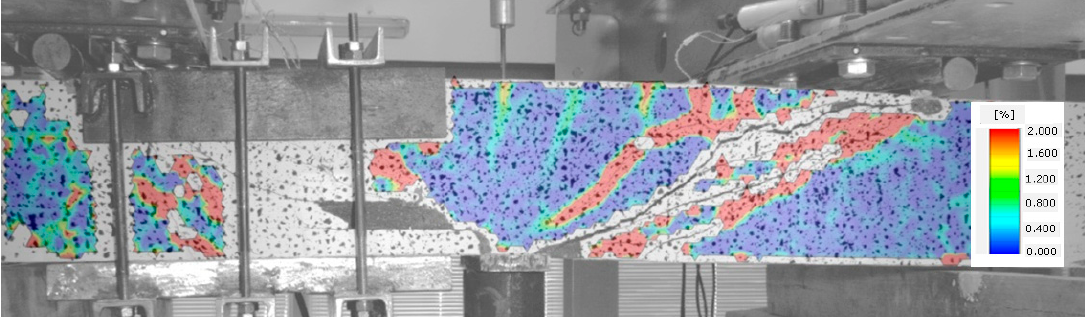
cracks originating in various element cross-sections are very important for its defor-